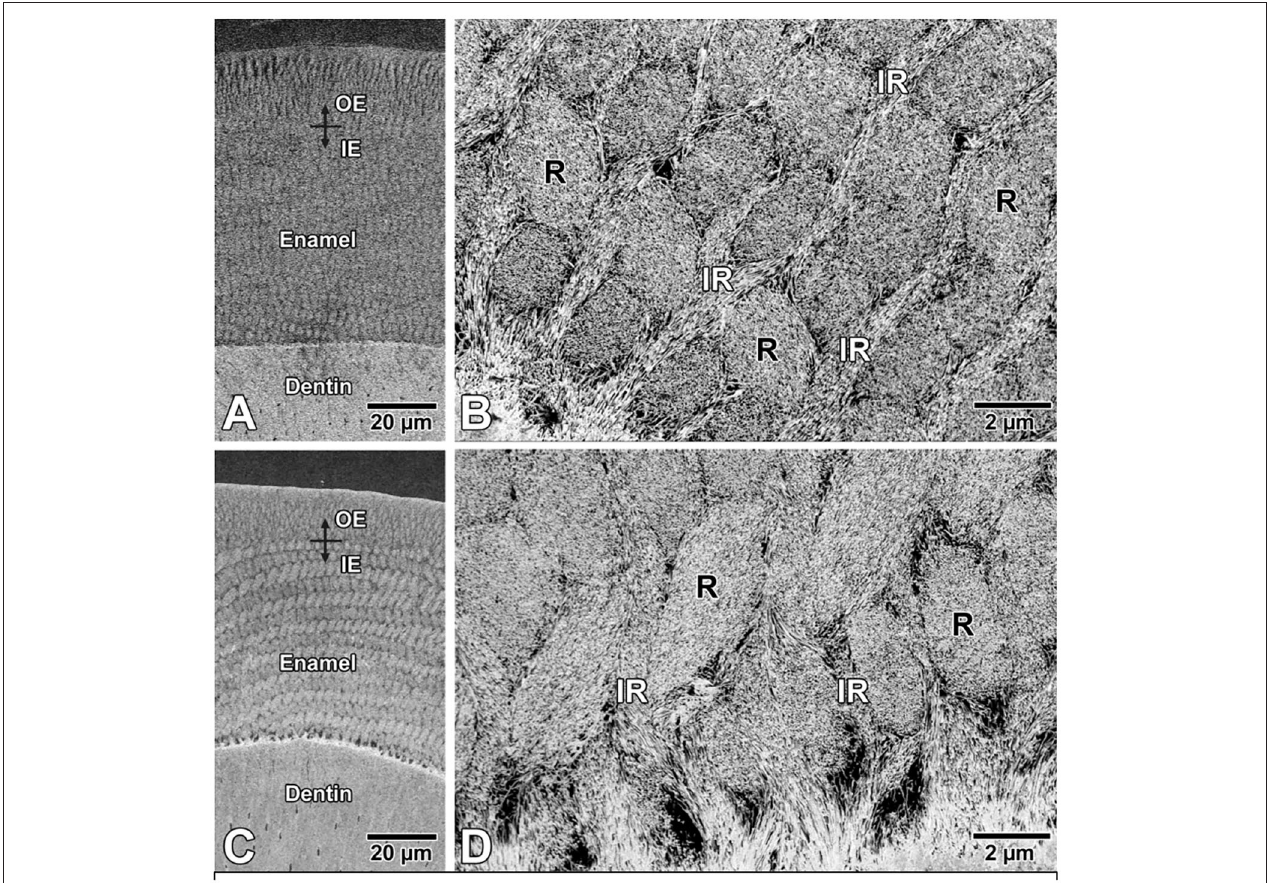
FIGURE 3 | Backscattered electron SEM images of enamel in (A,B) control and (C,D) ELA mice. Qualitatively, there are no differences in the structural organization of rod (R)-interrod (IR) enamel, and (B,D) also no apparent difference in appearance of crystal profiles. IE, inner enamel; OE, outer enamel.